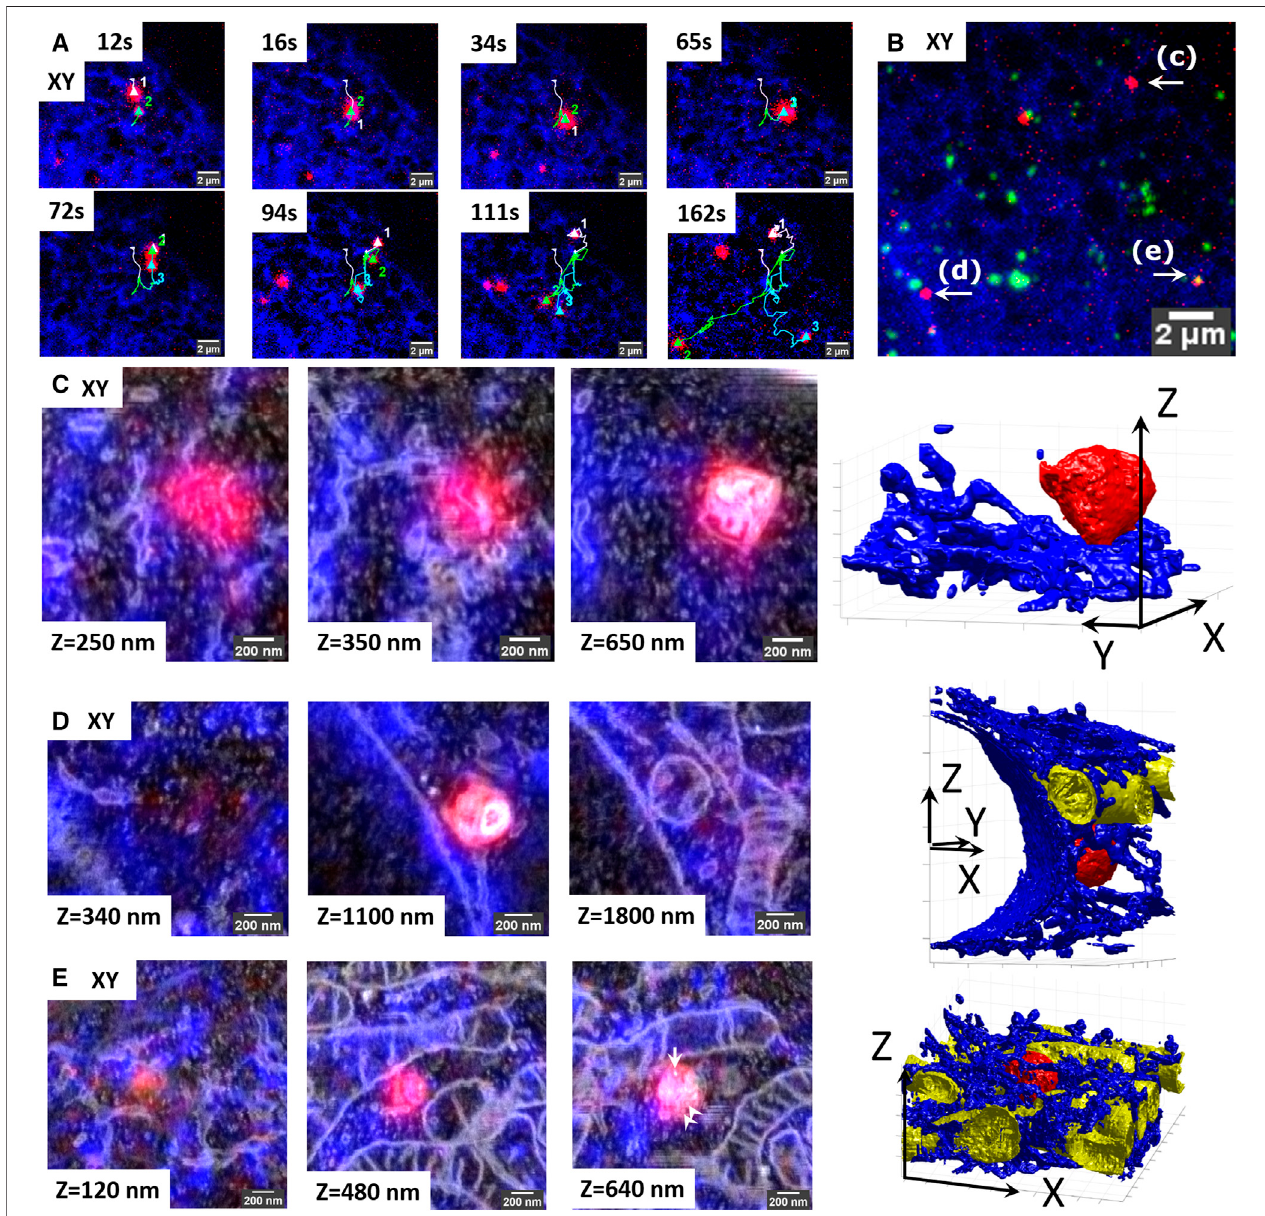
FIGURE 5 | Retracement of interacting organelles by targeted volume-CLEM. (A) Stills from the live-cell movie of three interacting lysosomes showing live lysosomes(SIRrLyso, red)andER(mEmerald-Sec61 β ,blue).Thelysosomesareinitiallyvisibleasseparate spots(65s)andthensplitintotwo(72s)andthenthree(94s) spots that travel in different directions. (B) Maximum intensity projection of the Z-stack made after in situ fi xation at 180 s. The Z-stack includes endocytosed fi ducial particles (green). The three interacting lysosomes tracked in live-cell imaging are indicated as (C – E) . (C – E) Each lysosome is traced back for volume EM, following thetargetedimagingroutine.Volume-CLEMimagesoflysosome#1 (C) ,lysosome#2 (D) ,andlysosome#3 (E) ,respectively,in2xyplanes,showingthesegmentationof the lysosomes (red), ER (blue), and mitochondria (yellow). Arrow points to the single endocytic fi ducial particle, and arrowheads depict the ILVs.